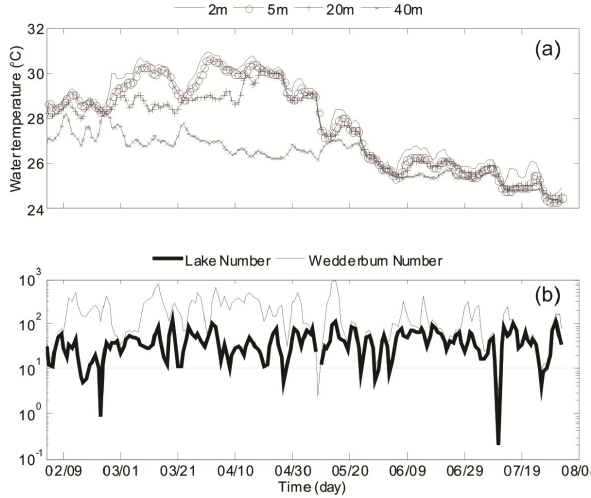
Figure 4: Temporal evolution of the thermal structure (upper panel) and the Wedderburn and Lake numbers (lower panel) at Station 13.